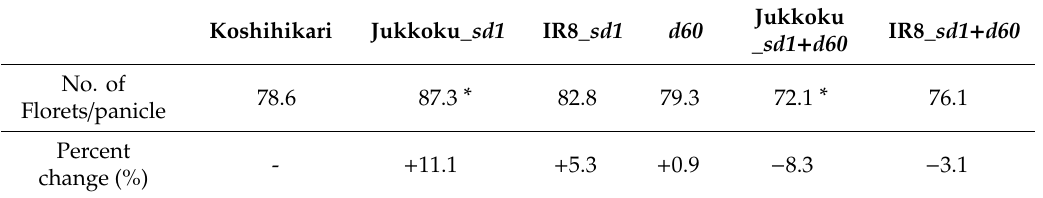
Figure 5. Floret number/panicle of semidwarf and double dwarf gene lines. The number of panicles/plants in line carrying d60 was comparable to that in line carrying IR8 _sd1 . Table 4. Effect of semidwarf and double dwarf genes to floret number/panicle.